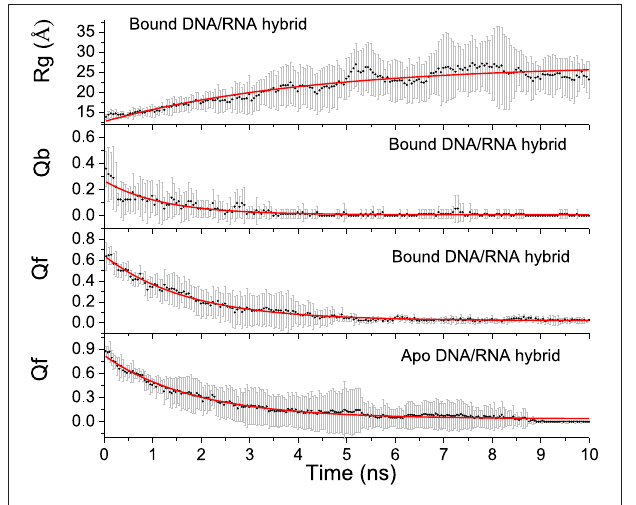
FIGURE 8 | Fitting of kinetics parameters for bound and apo-DNA/RNA hybrids.